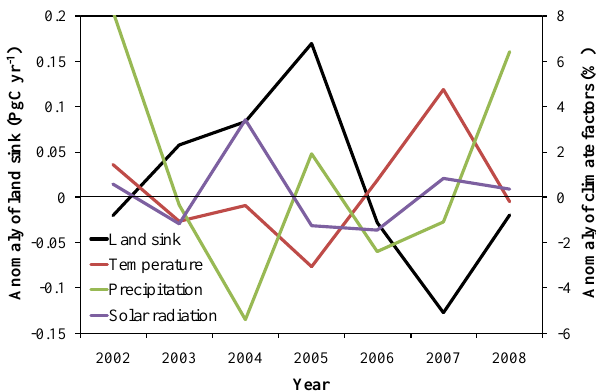
Fig. 7. Inter-annual variations of the anomaly of terrestrial carbon sinks and anomalous percentages of climate factors in